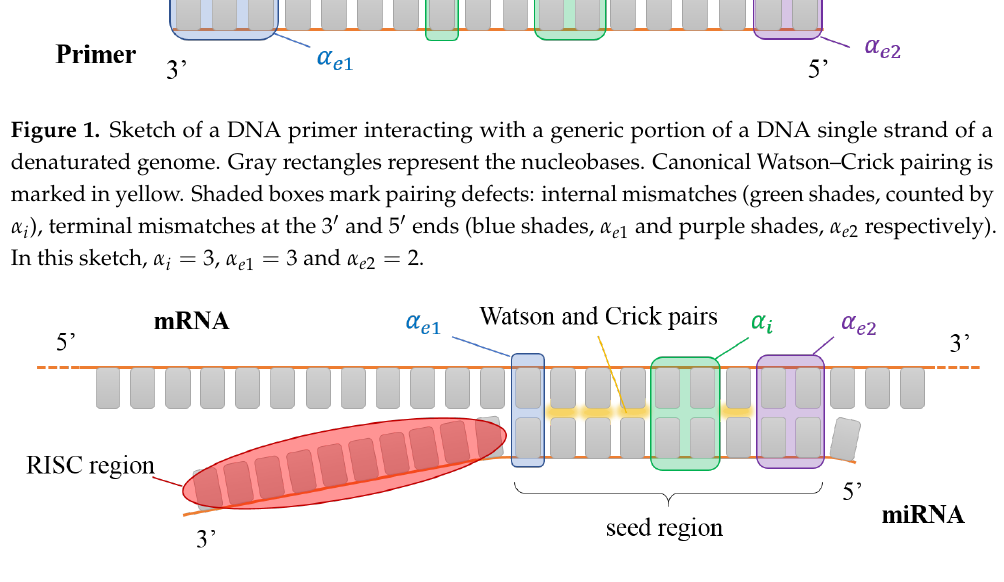
Figure 2. Sketch of a miRNA seed interacting with a generic portion of a mRNA. The nucleobases involved in the interaction with the AGO protein (red shading) are not available for pairing. Colored boxes have the same color code as Figure 1. In this sketch, α i = 2, α e 1 = 1 and α e 2 =